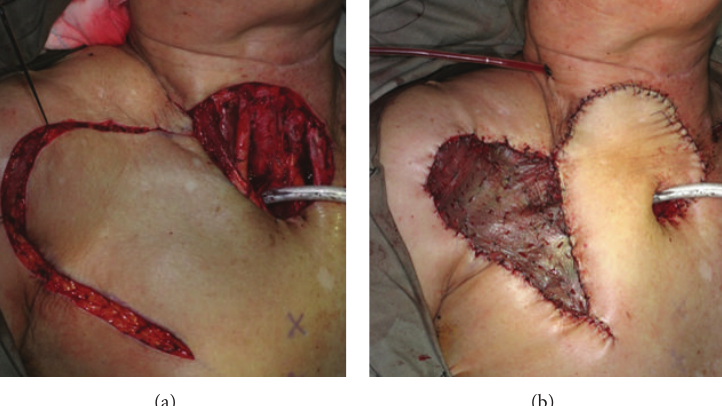
Figure 2: (a) Recurrent laryngeal carcinoma treated with total laryngectomy and skin resection. (b) DP flap covered the neck skin defect and augmented the posterior tracheal